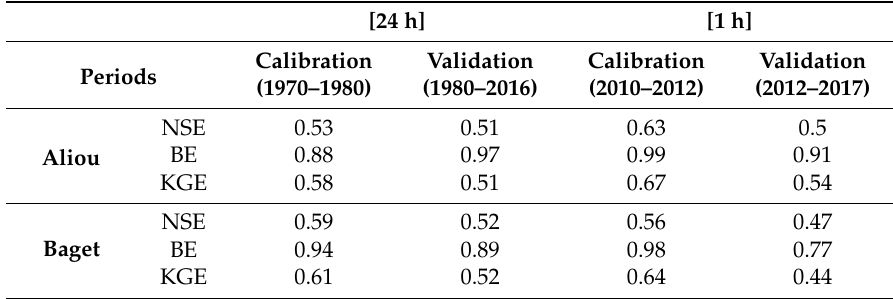
Table 3. Model performances for calibration and validation periods for daily and hourly KarstMod models (NSE: Nash Sutcliff Efficiency, BE: Balance Error and KGE: Kling Gupta